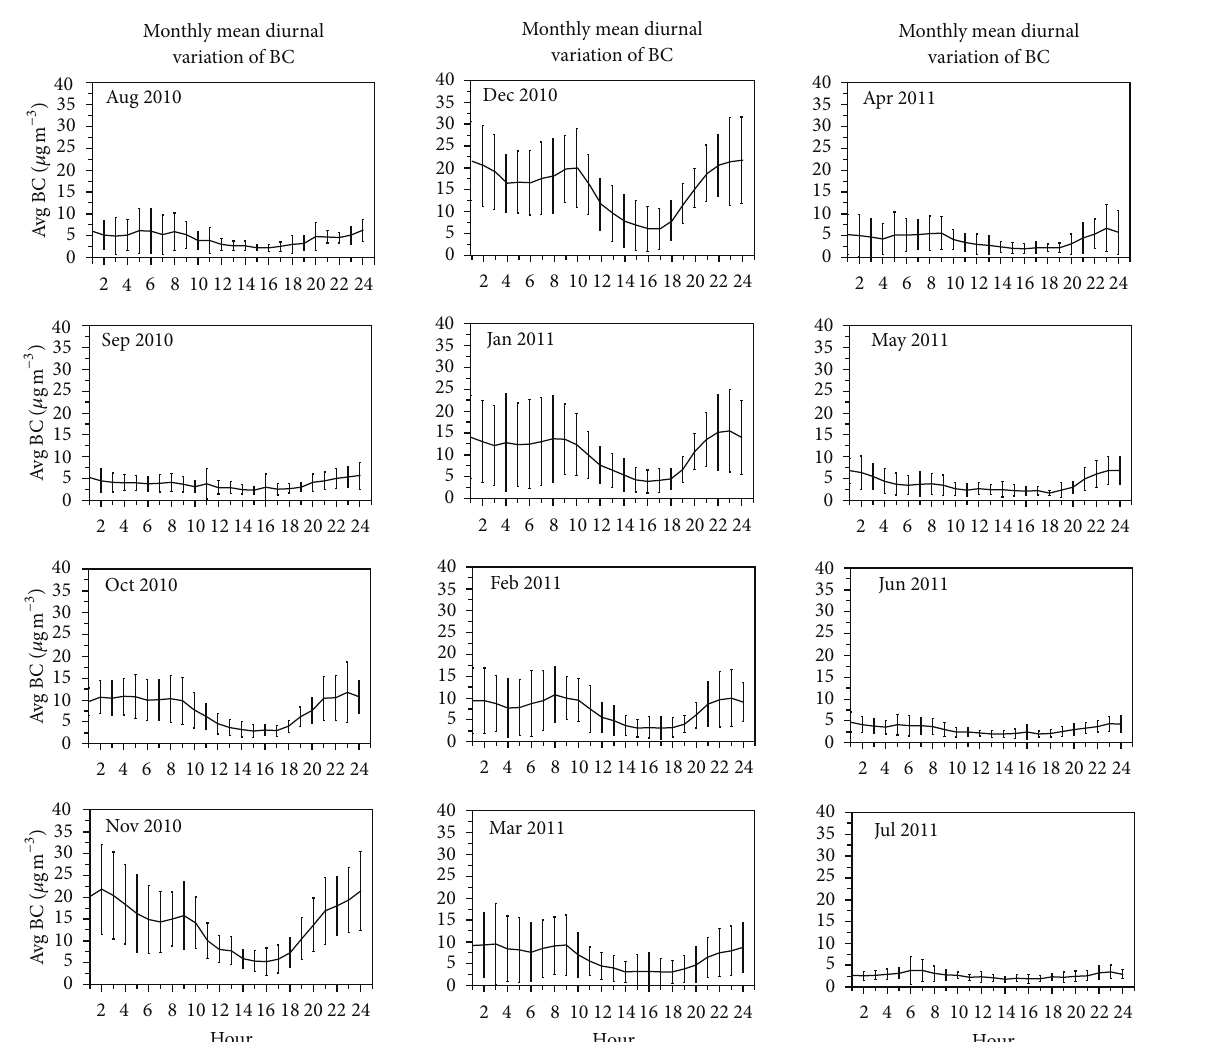
Figure 3: Monthly mean diurnal variation of BC mass concentration during August 2010–July 2011 over